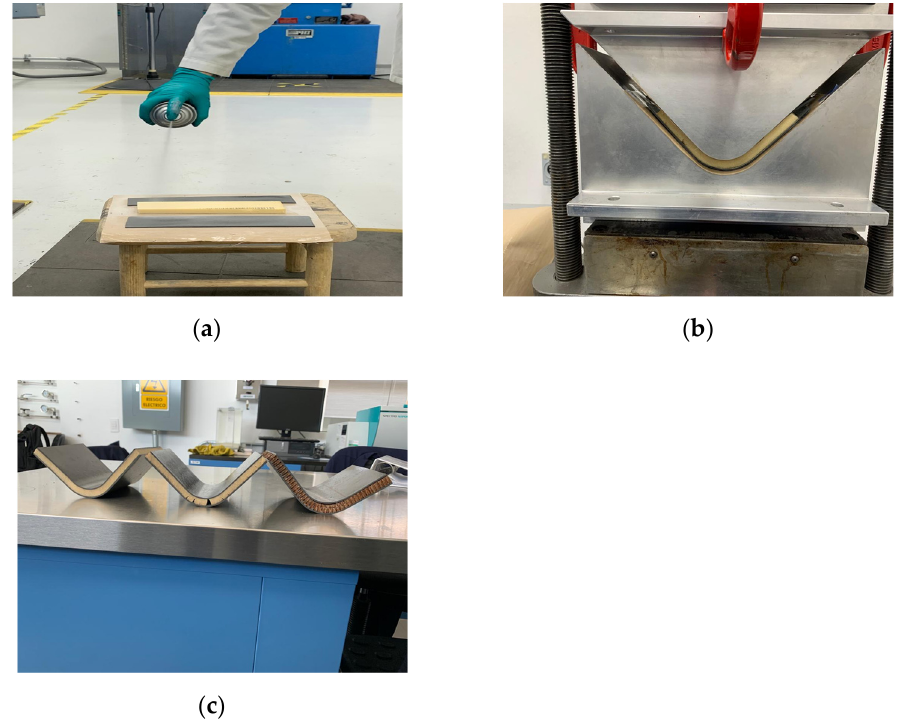
Figure 10. Pictures corresponding to the manufacturing procedure of V ‐ shaped ABS panels: ( a ) spraying adhesive mist aerosol to the foam and ABS sheets, ( b ) ABS/foam/ABS compression molding process, and ( c ) V ‐ shaped sandwich panels with face ABS sheets.